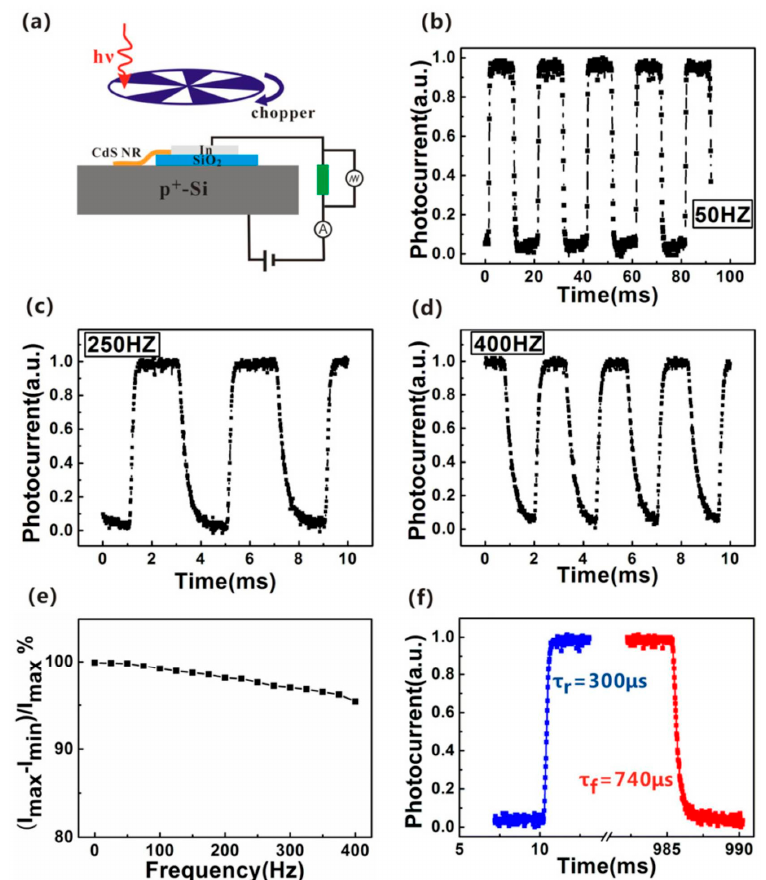
Figure 12. ( a ) Schematic illustration of the measurement configuration for photoresponse detection. Photoresponse characteristics of the CdSNR/Si heterojunction for pulsed light irradiation at frequencies of: ( b ) 50 Hz; ( c ) 250 Hz; and ( d ) 400 Hz. ( e ) The relative balance ( I max − I min switching frequency. ( f ) Enlarged rising and falling edges for calculating the rise and fall times. Reproduced with permission from [46], Copyright 2011, IOP Publishing Ltd.